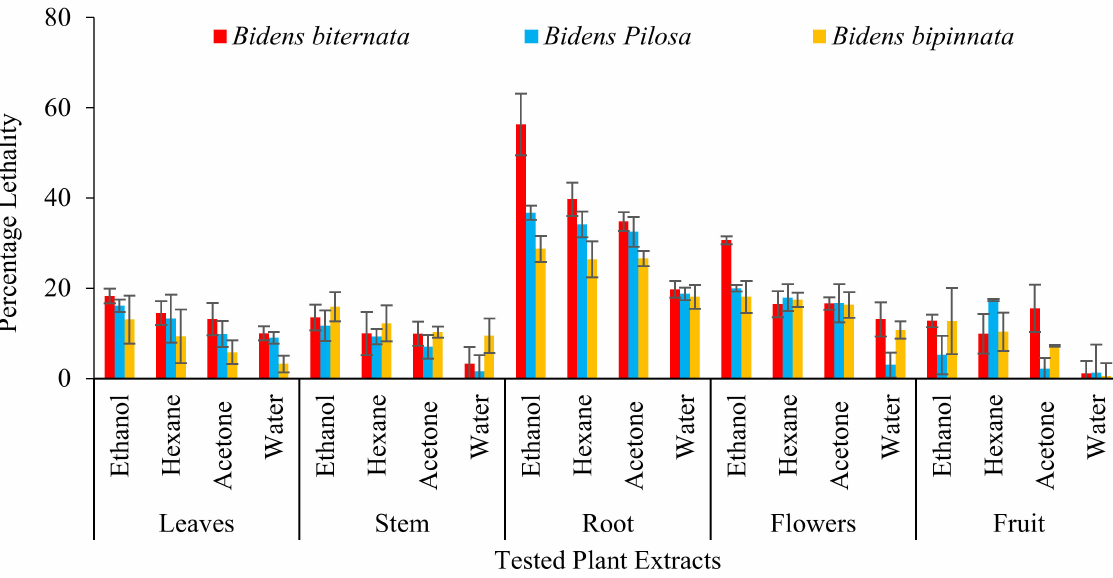
Figure 5. Toxicity assessment on Caenorhabditis elegans